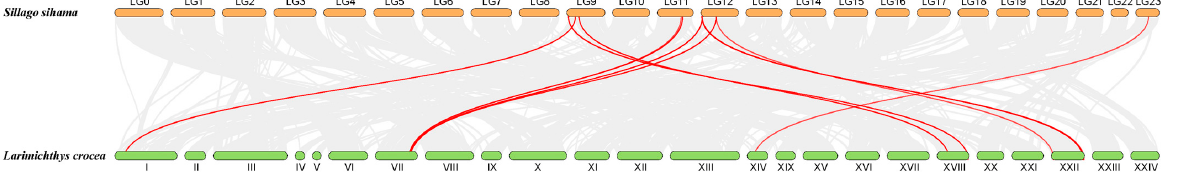
Figure 5. Collinearity relationship of OR genes in S. sihama and L. crocea. Orange bars represent the S. sihama chromosome. Green bars represent the L. crocea chromosome. The grey lines represent the collinearity relationship between S. sihama and L. crocea genes. The red lines represent the collinearity relationship between S. sihama and L. crocea OR genes.